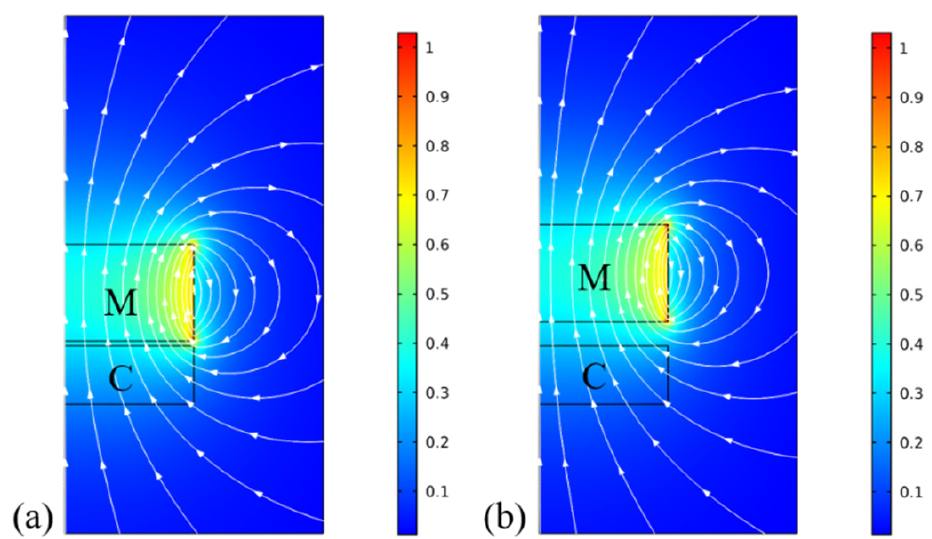
Figure 4. The magnetic flux of the magnet–coil structure based on a 2D axisymmetric FEM model at different magnet–coil distances: ( a ) 0.15 mm; ( b ) 0.75 mm.